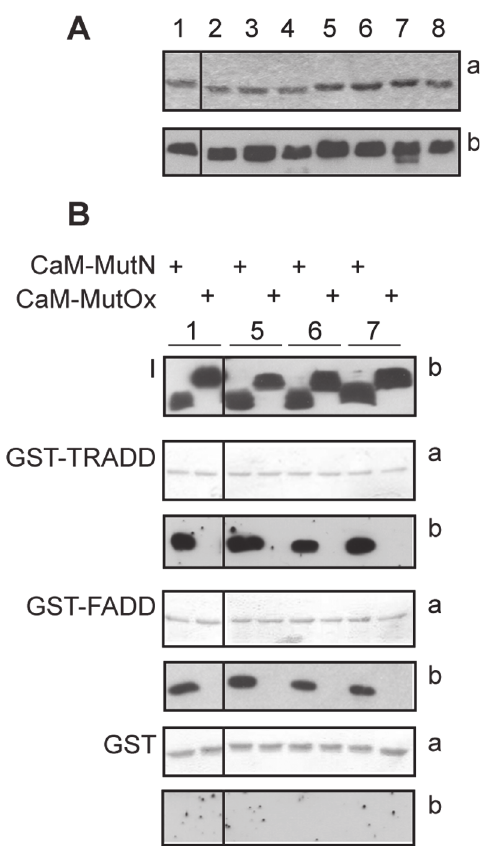
Figure 4. Effect of Met-to-Leu substitutions in CaM on FADD and TRADD binding. A : CaM mutants and SDS-PAGE analysis. Coomassie stained gel (a) and western blot analysis (b) of CaM mutants, identified by a numerical code detailed in Table 1. B : GST pull-down assays. Native (N) or oxidized (Ox) CaM mutants were incubated with the indicated GST proteins bound to glutathione-sepharose beads. 50% of the eluted proteins were analyzed by 12% SDS-PAGE and blotted to nitrocellulose stained with ponceau (a) and processed for western blot (b). I indicates the input of recombinant CaM proteins (250 ng). CaM mutants are identified by a numerical code as in Table 1. A and B : the black vertical lines in all panels indicate that non-adjacent lanes from the same gel or blots are shown. The data shown are representative of three independent experiments.